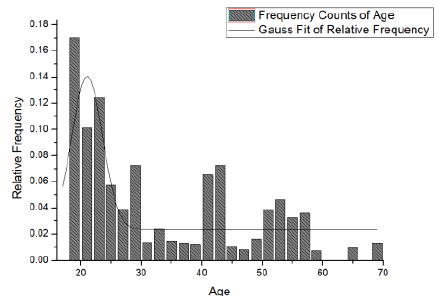
Figure 4. Driver age distribution. Table 8. Driver characteristics.